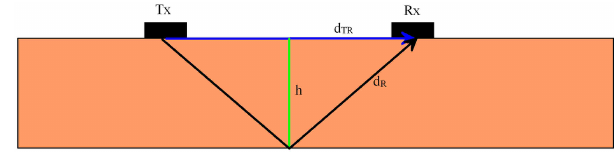
Figure 6. Schematic view of the distances between antennas (blue line), thickness of the wood sample (green line) and reflected-wave path (black line).